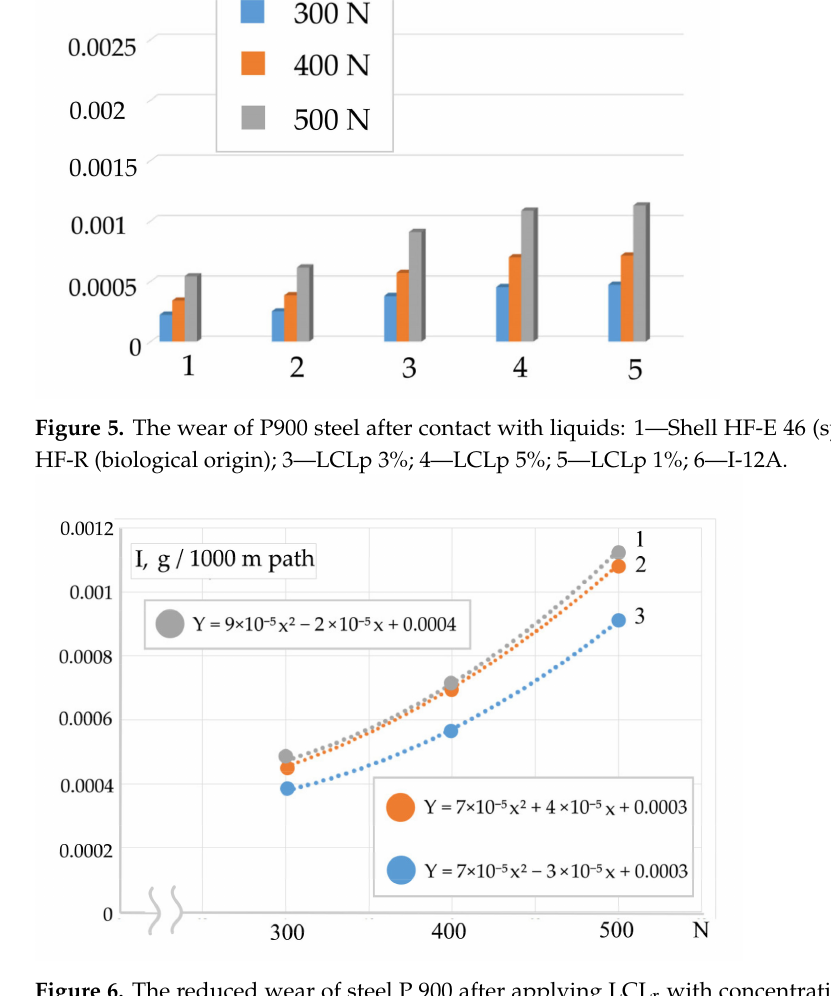
Figure 6. The reduced wear of steel P 900 after applying LCL r with concentration: 1—1%; 2—5%;